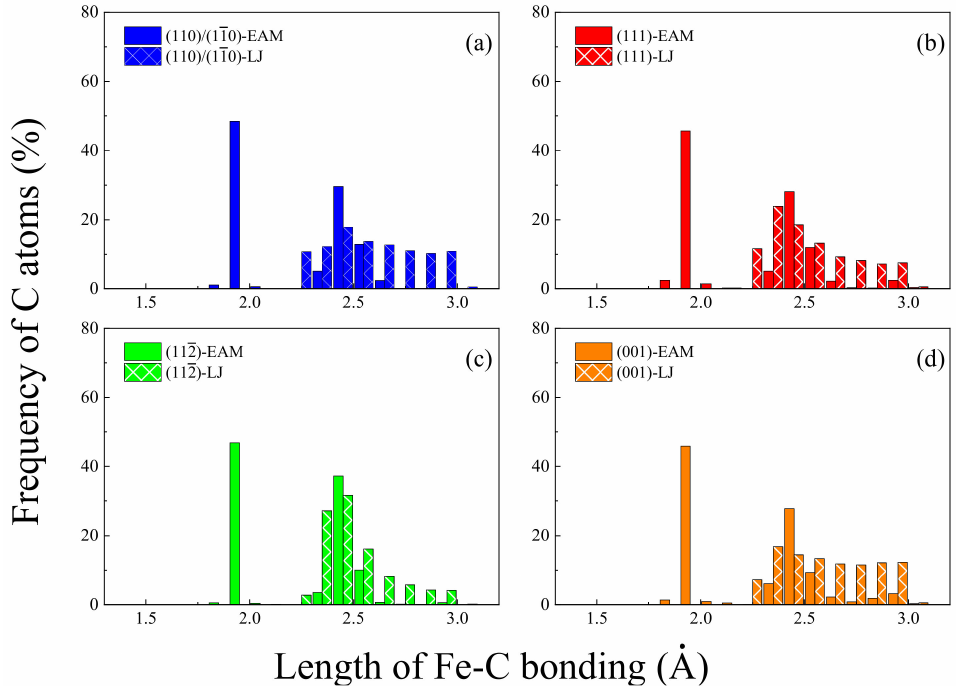
Figure 2. Distribution histograms of the length of Fe-C bonding ( L ) at the Gr/Fe ( a ) (110) or (110), ( b ) (111), ( c ) (112), and ( d ) (001) interface, respectively, calculated from MD simulations using LJ and EAM